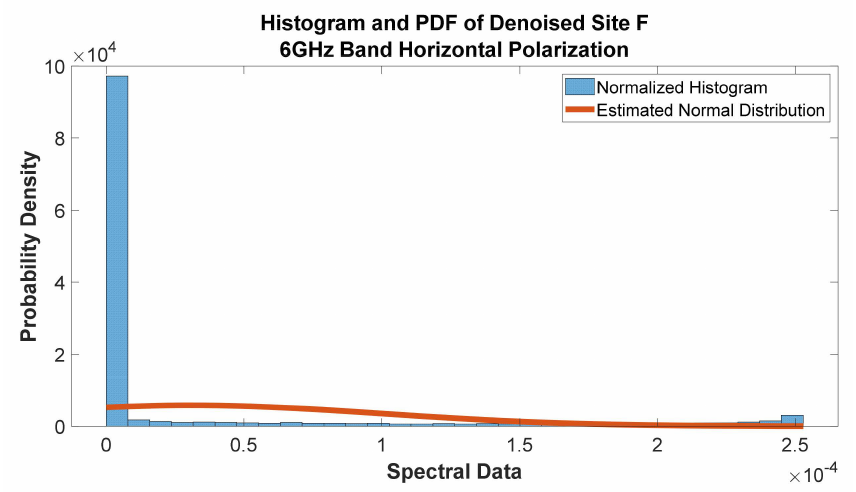
Figure 49. Histogram and PDF of site F at 6 GHz band horizontal polarization.